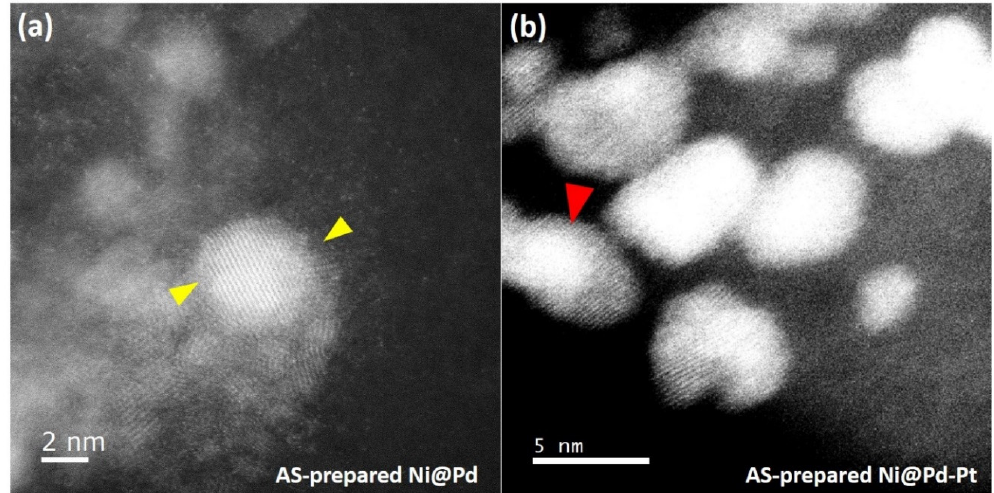
Figure 1. Aberration-corrected scanning transmission electron microscopy (AC-STEM) images